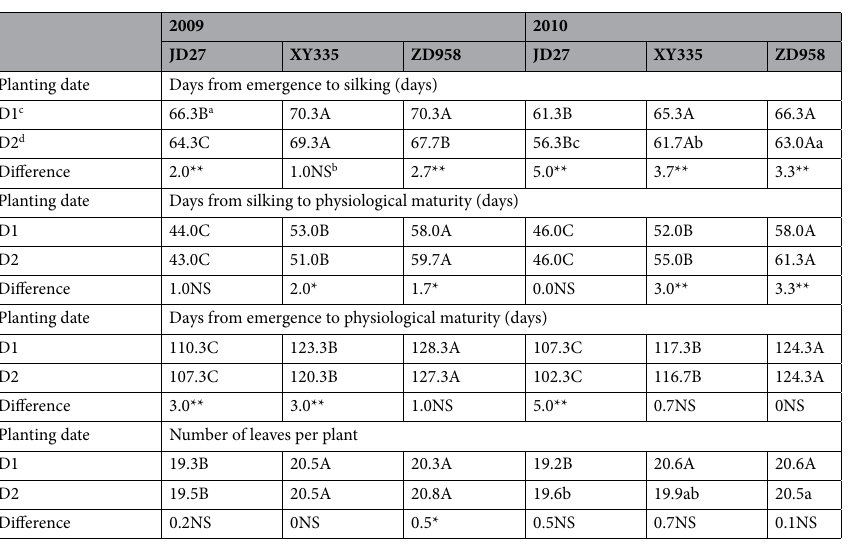
Table 2. Effects of planting date and hybrid maturity on days from emergence to silking, silking to physiological maturity, and emergence to physiological maturity, and number of leaves per plant of dryland corn at Lishu city, Northeast China during 2009 and 2010 growing seasons. a Means within a row followed by a different lower-case letter differ at P < 0.05. Means within a row followed by a different upper-case letter differ at P < 0.01. b NS, not significant. c D1 represents the planting date of maize in early May. The planting dates for 2009 and 2010 were May 2 and May 4, respectively. d D2 represents the planting date of maize in mid-May. The planting dates for 2009 and 2010 were May 12 and May 14, respectively. *Significant at the 0.05 level. **Significant at the 0.01 level.